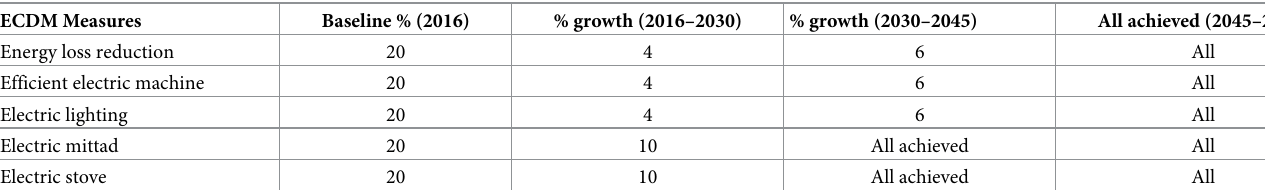
Table 4. Annual percent of replacing the efficient energy